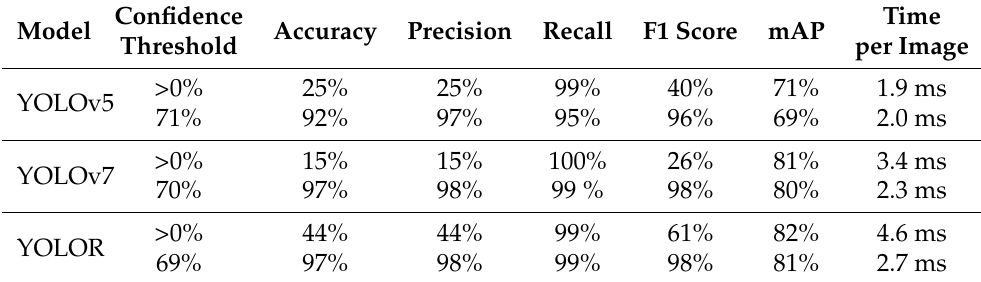
Table 10. Detection results of the testing set obtained from the Flower Detection